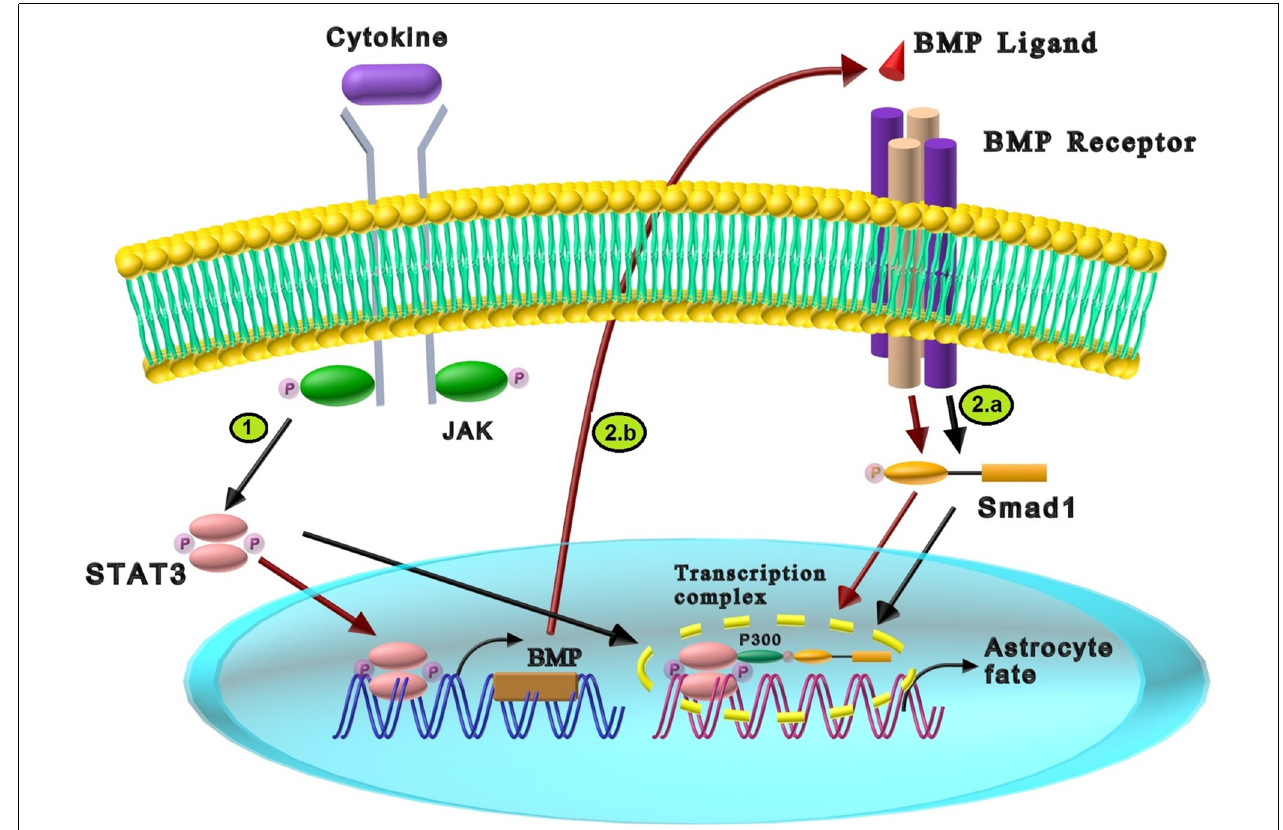
FIGURE 3 | The cross-talk between BMP and cytokines signaling pathway in neural differentiation. (1) The interaction of cytokines and JAK components results in STAT3 phosphorylation and dimerization. Dimerized STAT3 is translocated into the nucleus, leading to astrocyte differentiation. (2) The synergistic effects between cytokines and BMP signaling in astrocyte differentiation are exerted through two different pathways: (a) LIF induces STAT3, while BMP2 activates Smad1 through their receptors. p300, a transcriptional coactivator, interacts with STAT3 and Smad1 resulting in the formation of STAT3/Smad1/p300 transcriptional complex and promotion of astrocyte differentiation (Black arrows). (b) Cytokines (LIF), can create a booster para-regulatory pathway in which activated STAT3 increases the expression of BMP2. The presence of BMP2 increases the activated Smad1 which induces astrogliogenesis (Red